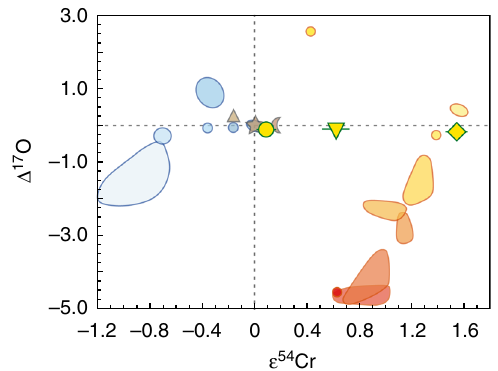
Fig. 4 Δ 17 O vs. ε 54 Cr in impact glasses and tektites from this study compared with chondrites, achondrites and large planetary bodies. The plot is modi fi ed from refs. 3, 26, 58 with new data from this study plotted as yellow symbols ( circle — SBM-88; reversed triangle — IR-7; diamond — IR-8), with 2 s.e. uncertainties plotted. For oxygen, the error bars are smaller than the corresponding symbol size. Different hues of orange from light to dark represent different classes of carbonaceous chondrites (CI, Tagish Lake, CR, CB, CM, CV, CO, CK — red spot ), the single point with high Δ 17 O ~2.5 ‰ represents Rumuruti chondrites. Different hues of blue from light to dark represent ureilites (farthest from Earth), mesosiderites – HED meteorites – pallasites – IIIAB irons group, ordinary chondrites, aubrites, angrites and enstatite chondrites (near-identical to Earth). Triangle — Mars; star — Earth; crescent —